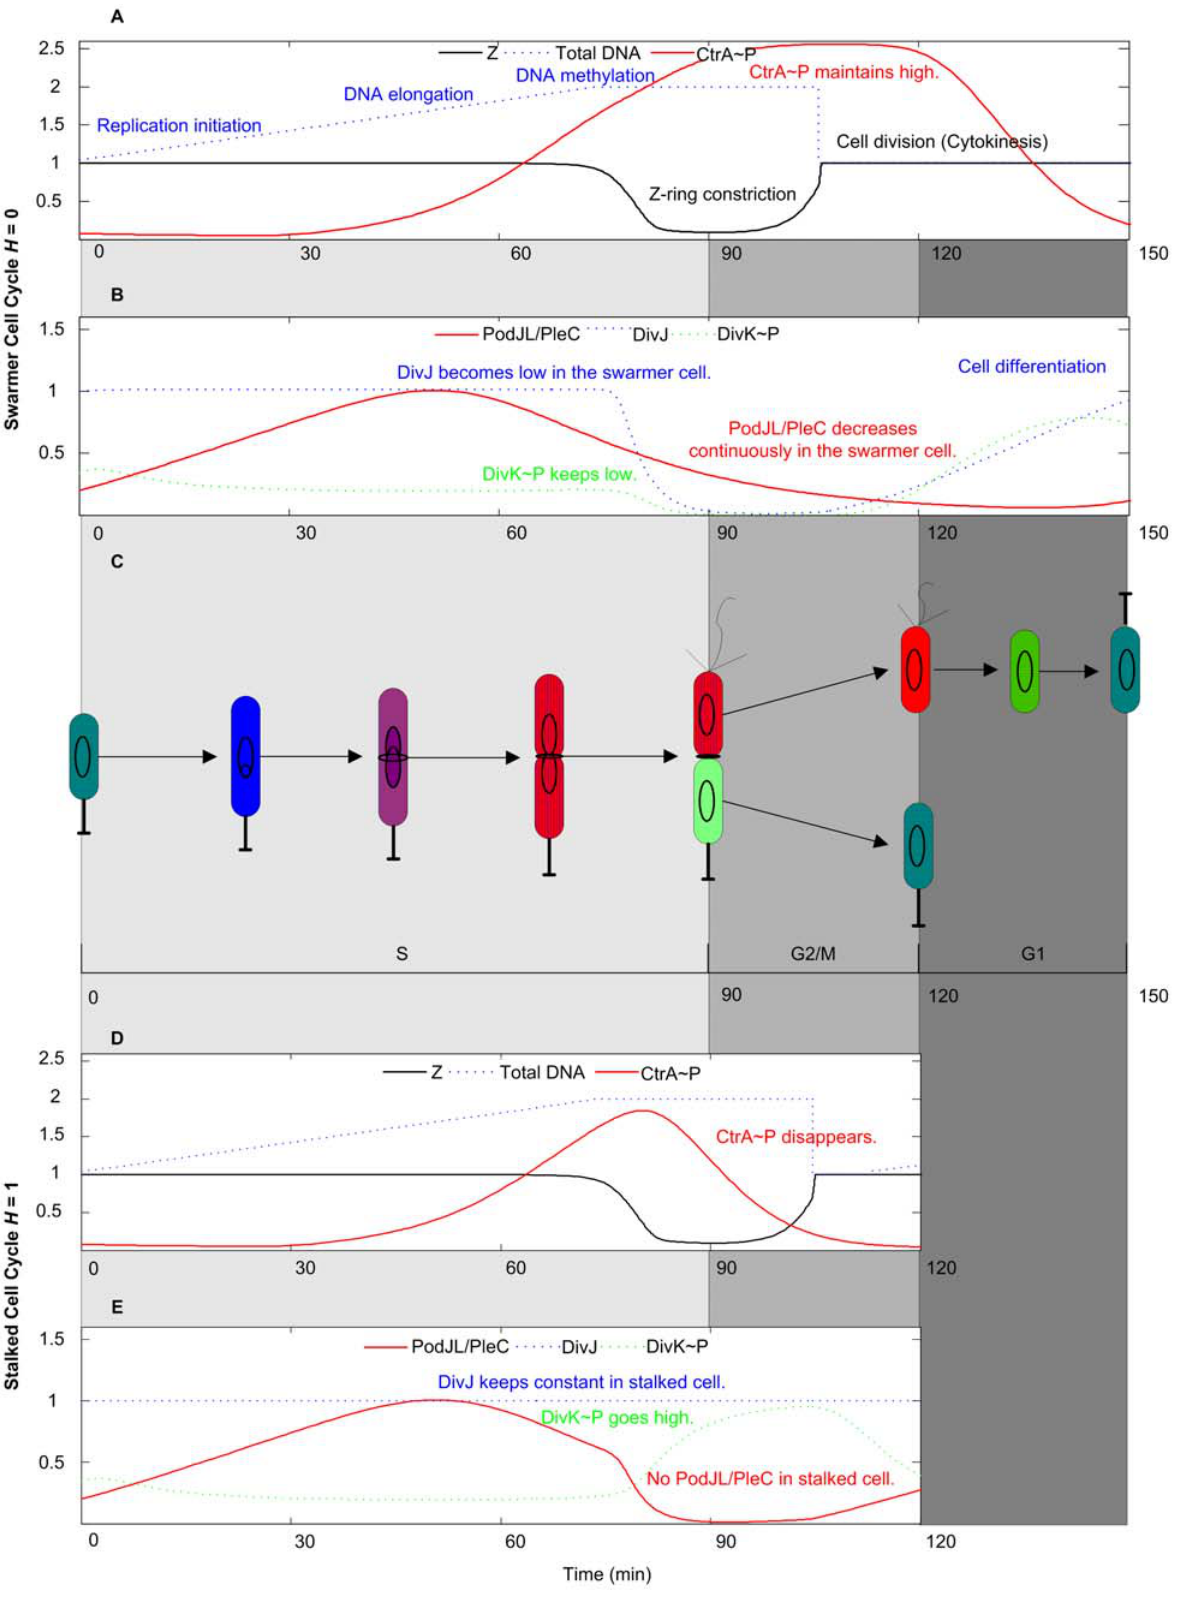
Figure 3. Correlations between protein levels and the physiological features of a dividing Caulobacter cell. Time courses of protein expressions, DNA replication and Z-ring states produced by our model for the swarmer cell cycle (A, B) and for the stalked cell cycle (D, E). Physiological changes during cell cycle progression are shown in panel C.